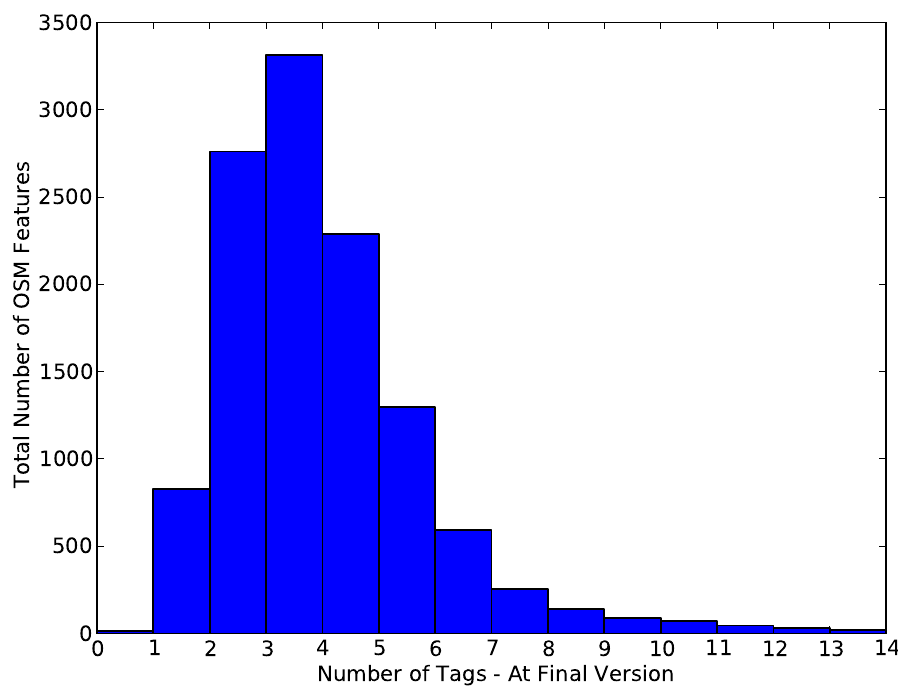
Figure 4. Distribution of the number of tags from all objects in the case study.